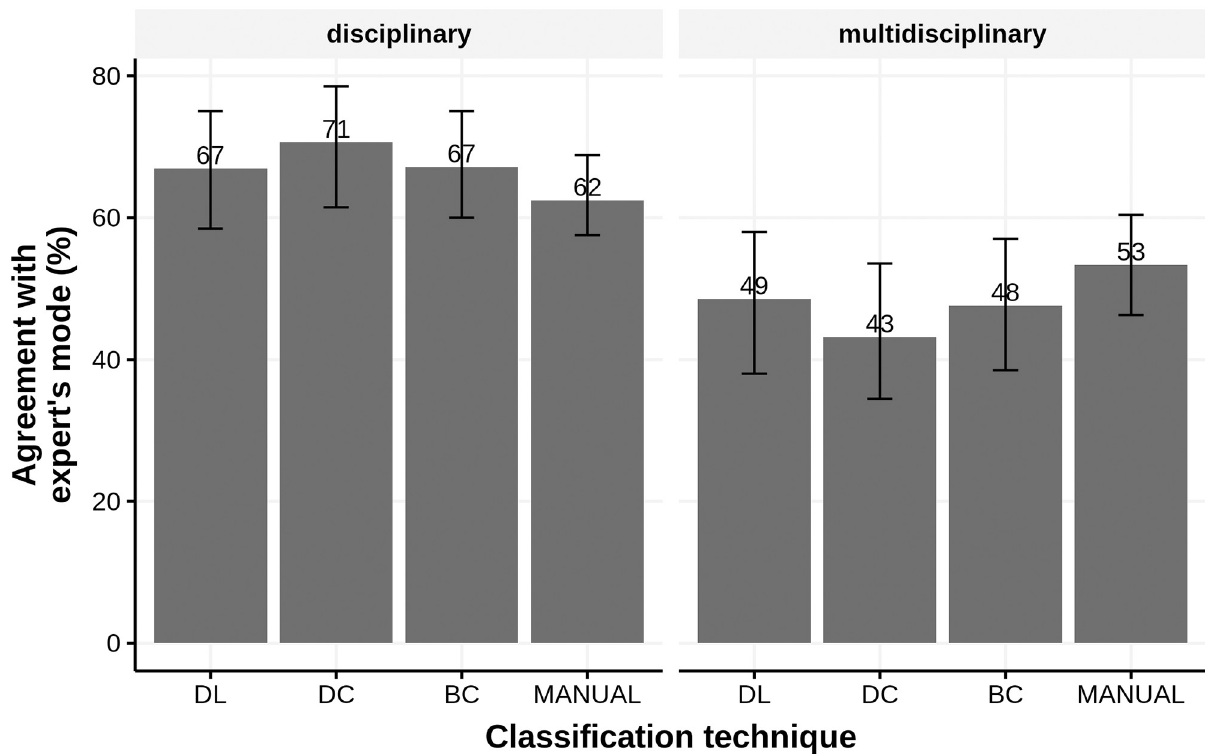
Fig 5. Agreement (%) between computational and manual article classification. Two datasets (disciplinary vs. multidisciplinary) of 100 papers were classified by five and six experts respectively to find the modal classification of each article.